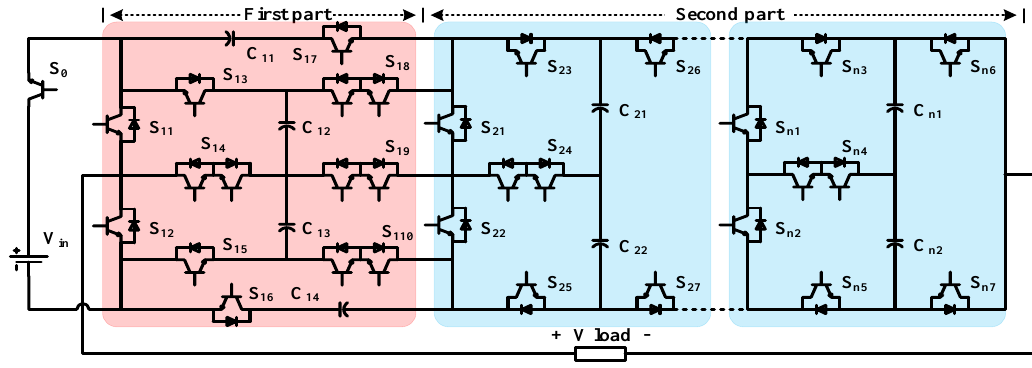
Figure 1. The overall structure of the proposed switched capacitor multilevel inverter (SCMLI).